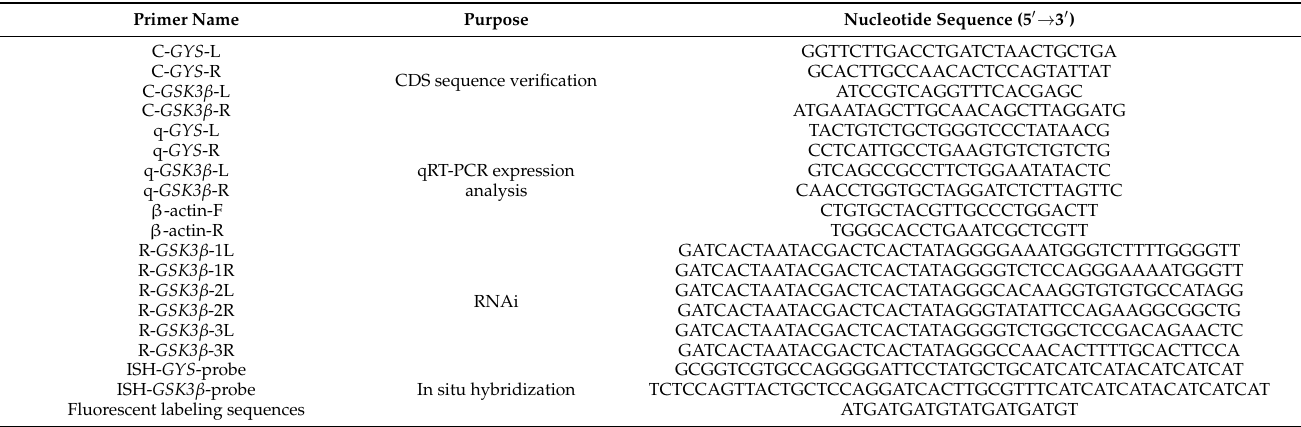
Table 1. Primers used for the